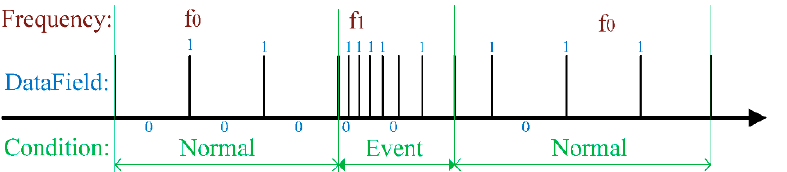
Figure 2. The mechanism of the generic object-oriented substation event (GOOSE) repetition.